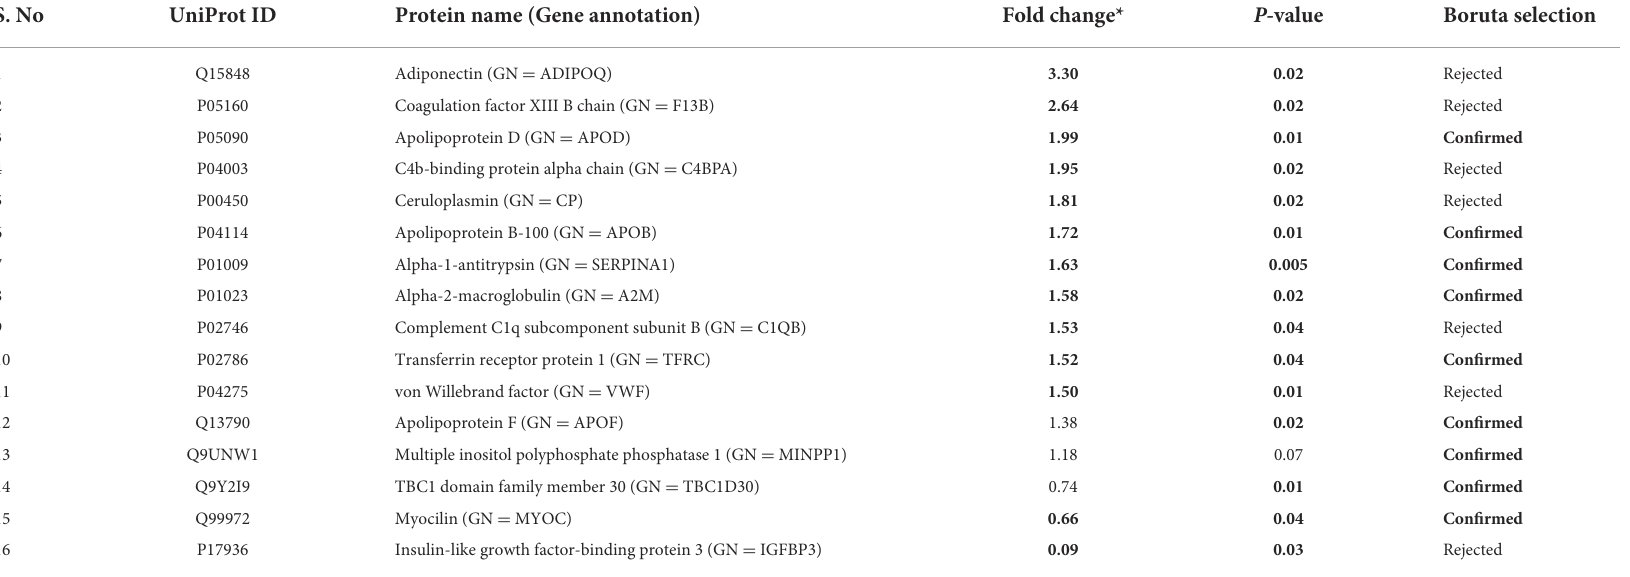
TABLE 3 List of significantly differentially expressed proteins between ischemic stroke and healthy controls using fold change with p- value and Boruta random forest feature selection criteria. S.